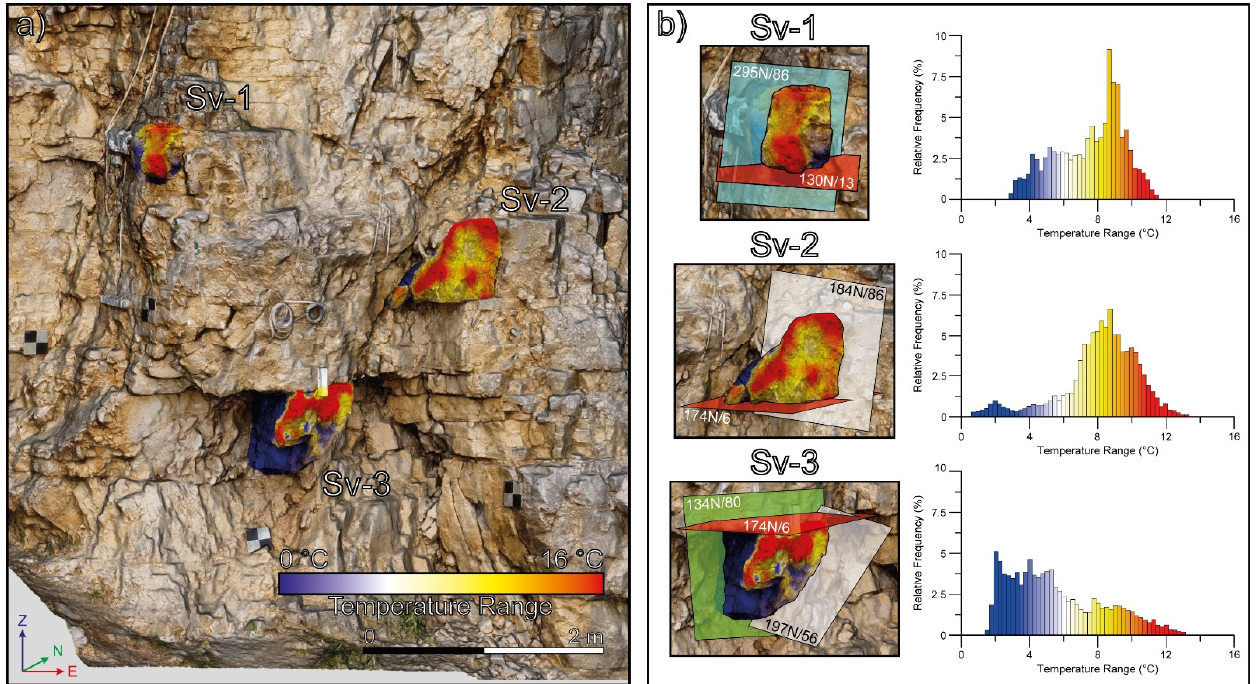
Figure 13. ( a ) Three sub-volumes (Sv-1, Sv-2 and Sv-3), considered as potentially unstable due to the presence of persistent discontinuities which isolate them from the rock mass, have been identified and represented in a color-scaled view in order to highlight their peculiar distribution of surface temperature ranges. ( b ) For each of the identified sub-volumes, through the reconstruction of merged thermal and optical point clouds, it will be possible to assess both their thermal behavior, by analyzing temperature distribution and evolution, and geomechanical conditions, by identifying structural elements which can constrain their stability.